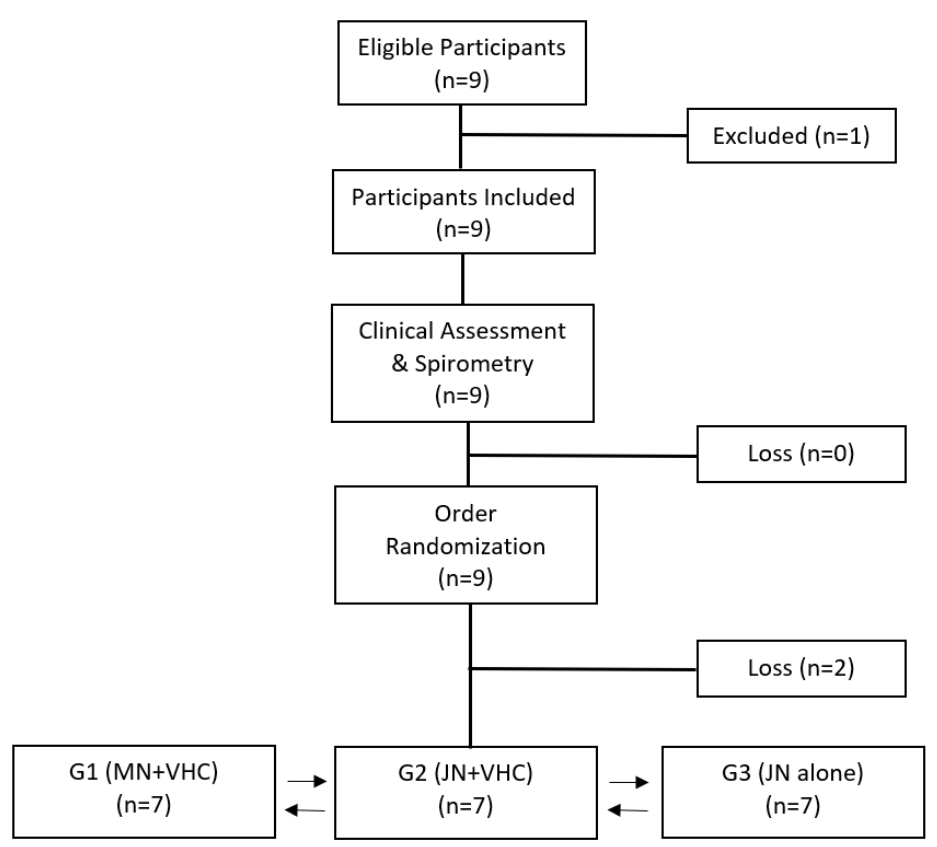
Figure 2. Volunteer recruitment and follow-up flowchart according to the CONSORT (Consolidated Standards of Reporting Trials) statement. MN + VHC: mesh nebulizer with the valved holding chamber, JN + VHC: jet nebulizer with the valved holding chamber, and JN alone: jet nebulizer without the VHC. Table 1. Means and standard deviations (SD) of anthropometric and clinical characteristics of study participants. (BMI: body mass index; HR: heart rate; BPM: beats per minute; RR: respiratory